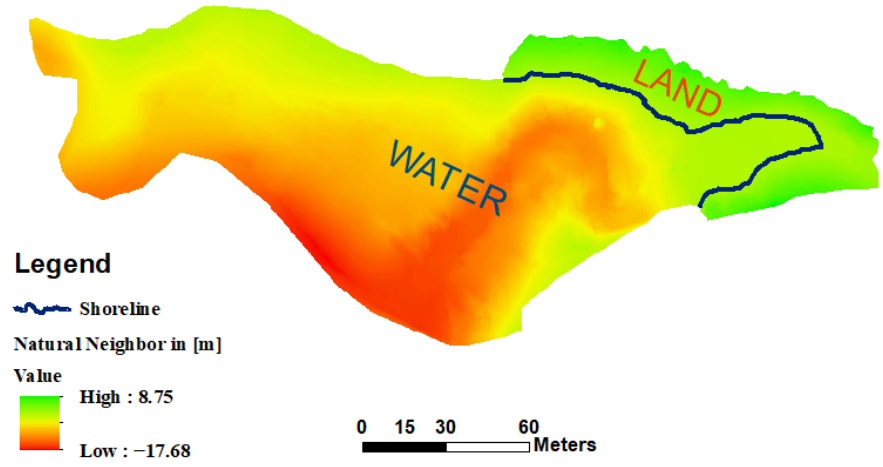
Figure 12. Resulting DSM based on Natural Neighbor interpolation for the entire